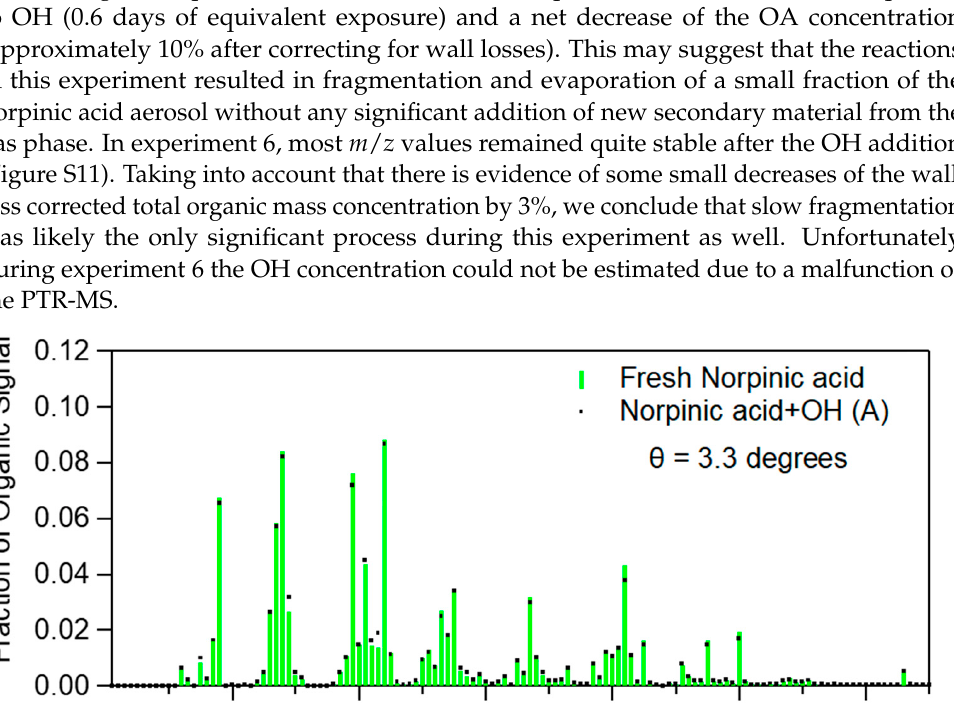
Figure 5. The mass spectrum of the: ( a ) fresh and ( b ) aged norpinic acid aerosol derived from the PMF analysis of the AMS measurements in experiment 2.